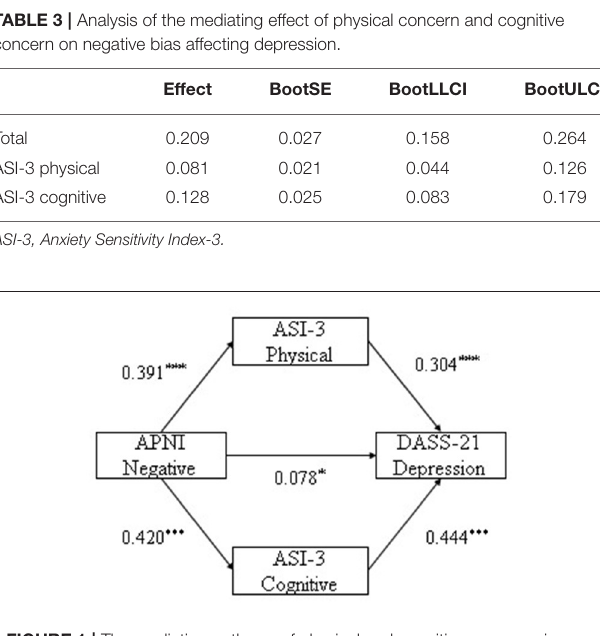
FIGURE 1 | The mediating pathway of physical and cognitive concerns in negative bias influence depression. * p < 0.05, ** p < 0.01, *** p <